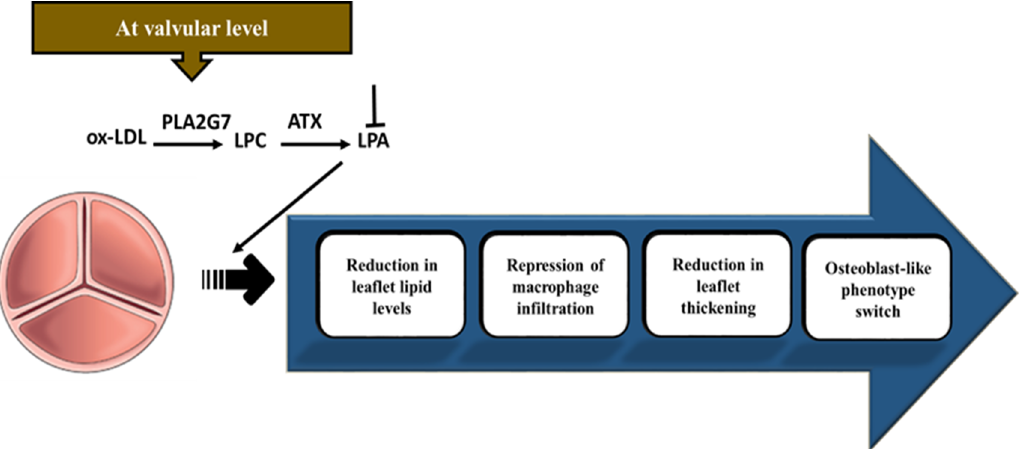
Figure 1. The implication of Ox-LDL in the calcification of the aortic valve. The infiltration of Ox-LDL into the aortic valve activates inflammation and, consequently, the release of PLA2G7 from macrophages, leading to the production of LysoPC. The activation of autotaxin leads to the preproduction of LPA, which amplifies the inflammation and the activation of the osteoblastic-like phenotype